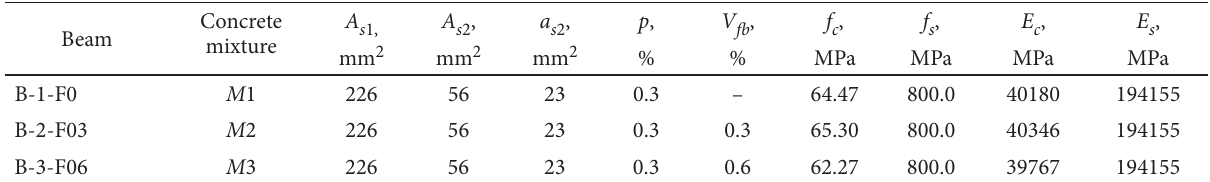
Table 2. Geometry and material parameters of the full-scale beams Concrete Beam mixture